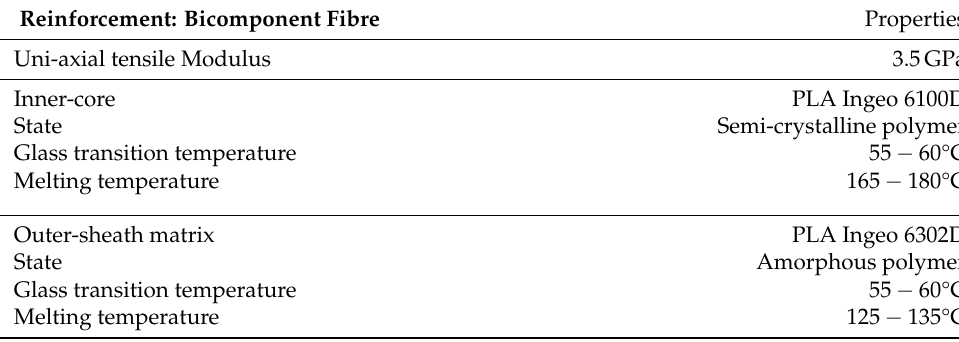
Table 4. Material properties of the bicomponent fibre (inner-core and the outer-sheath matrix). Reinforcement: Bicomponent Fibre